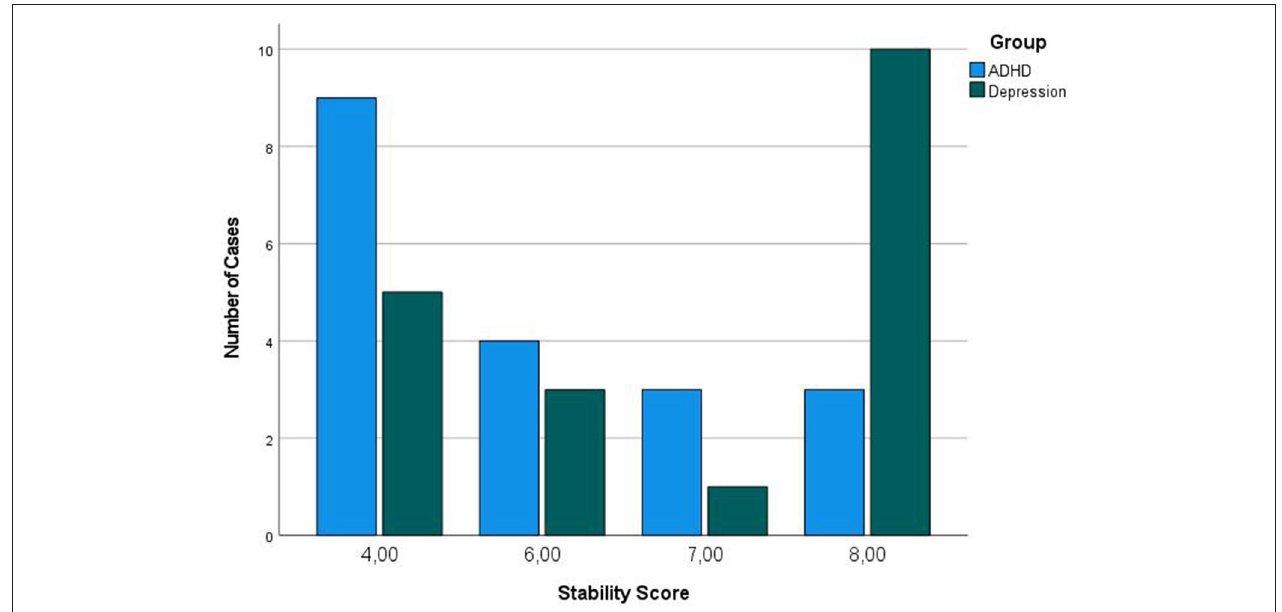
FIGURE 2 | EEG stability distribution between diagnostic groups. Here are shown the vigilance stability index distribution in the age-matched subsample with 19 participants in each diagnostic group. For stability score, see Table 1 ; lower stability value means faster vigilance decline. The stability distribution was different between the groups: Pearson Chi-Quadrat